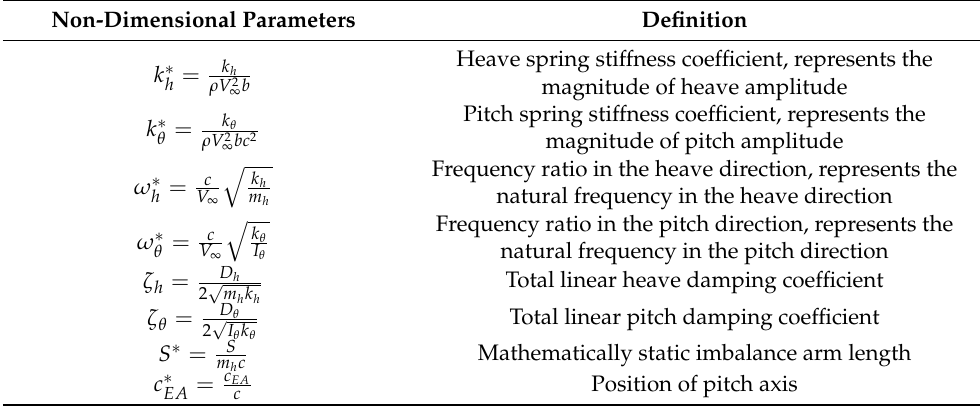
Table 2. Non-dimensional parameters of double-elastic-constrained foil system.